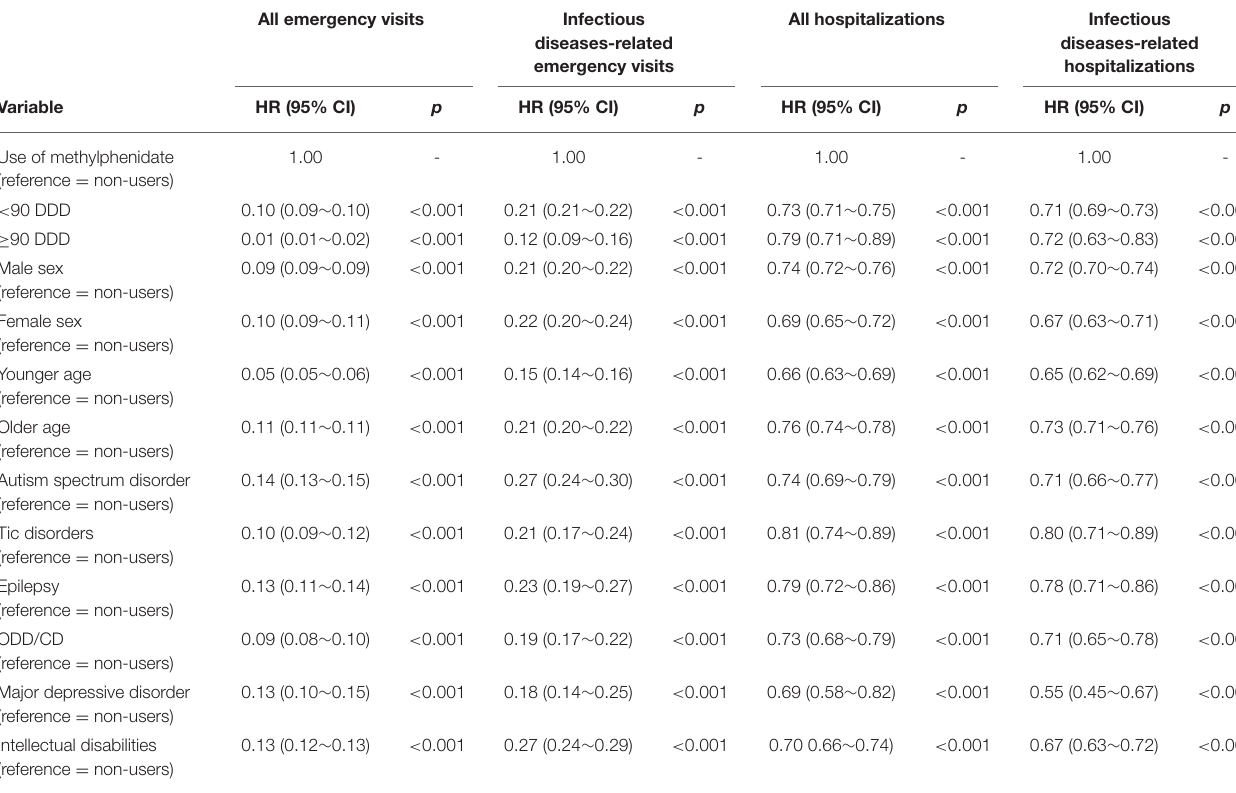
TABLE 3 | Cox proportional hazard regression model analysis with the use of methylphenidate on hospitalizations or emergency room visits in ADHD youth stratified by demographic variables and